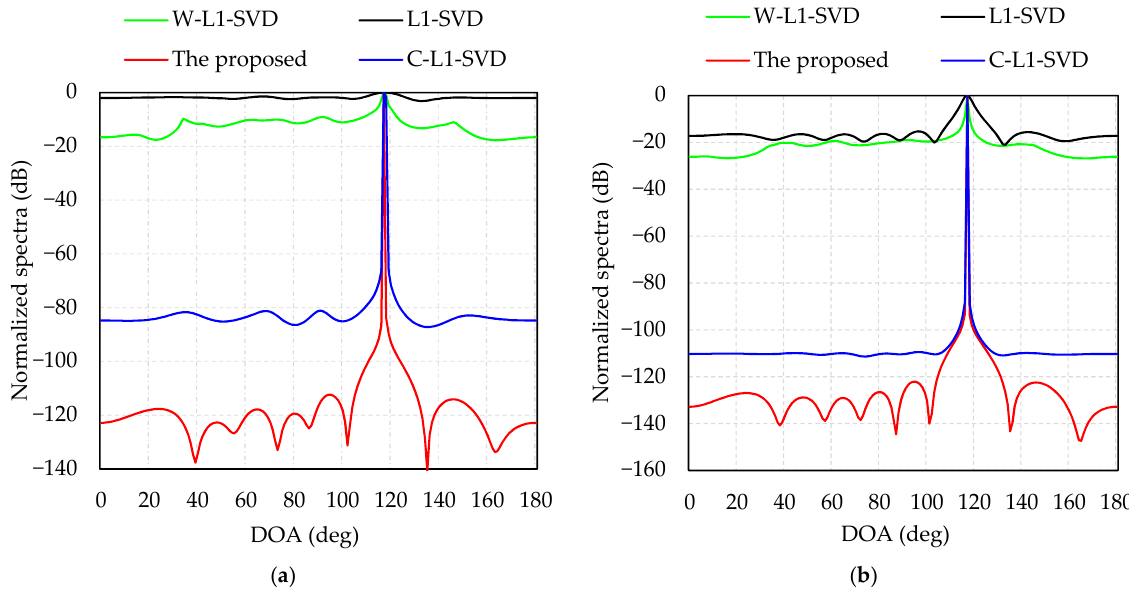
Figure 2. Normalized spectra of four algorithms: ( a ) SNR = − 12 dB; ( b ) SNR = 0 dB.